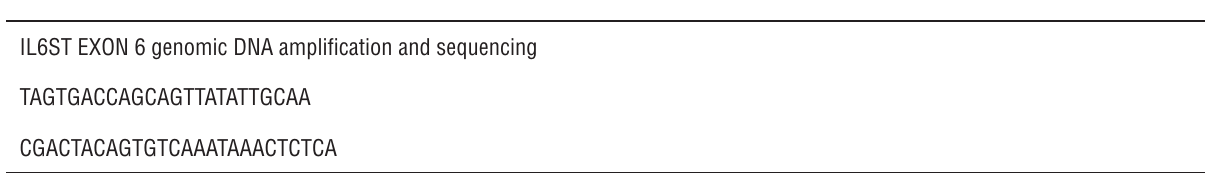
Table 1 - Sequence primer 5'->3'. IL6ST EXON 6 genomic DNA amplification and sequencing TAGTGACCAGCAGTTATATTGCAA